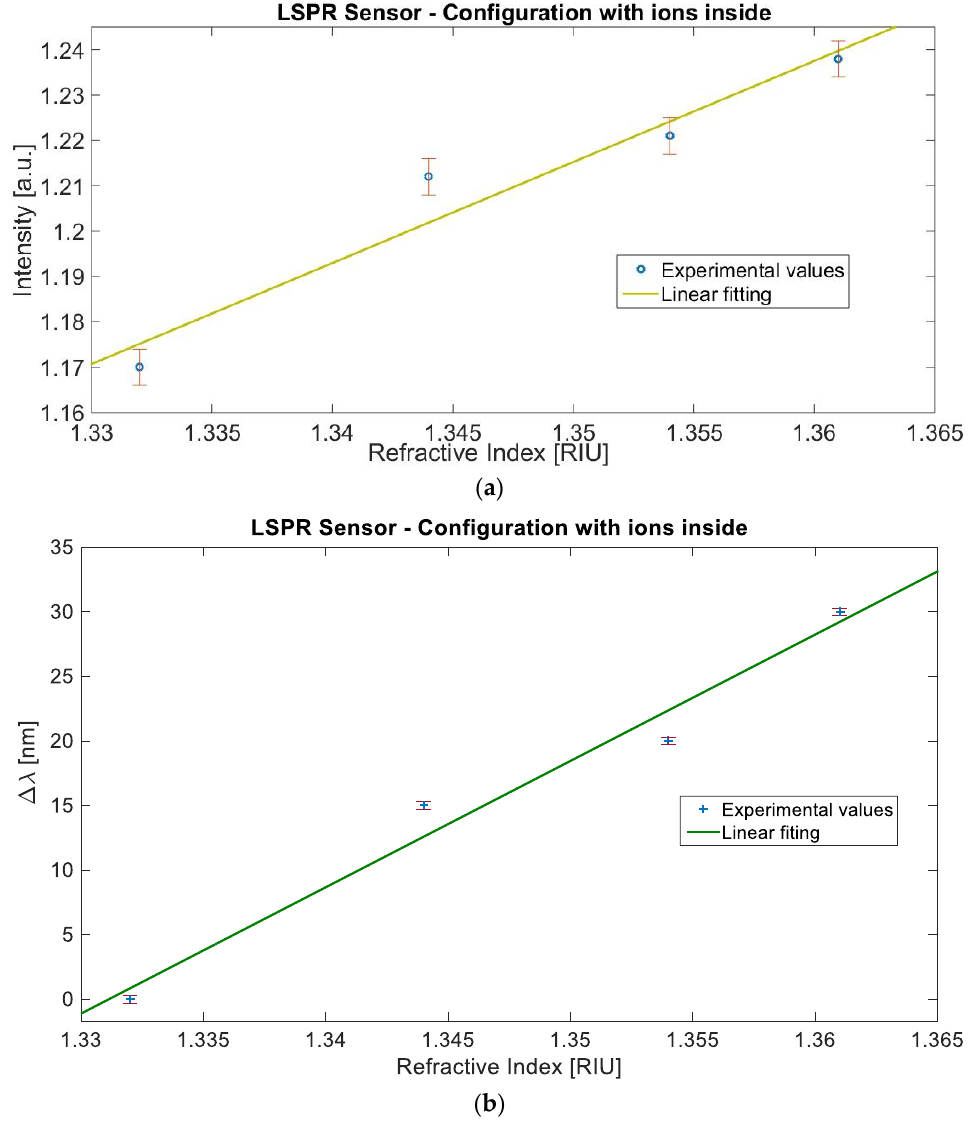
Figure 5. Experimental results of the sensor based on BC paper with ions: Measured values versus the refractive index, with the error bars and the linear fitting of the data. ( a ) Intensity value versus refractive index. ( b ) Resonance wavelength shift value versus refractive index.